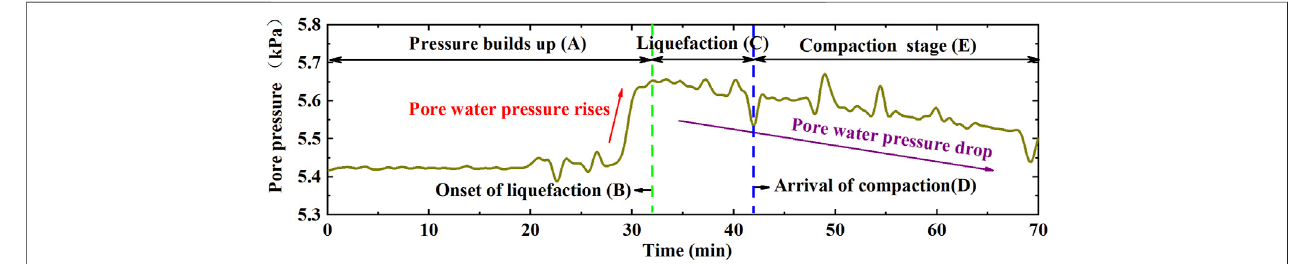
FIGURE 3 | Variation of periodic-average pore-water pressure with time at 10 cm depth.